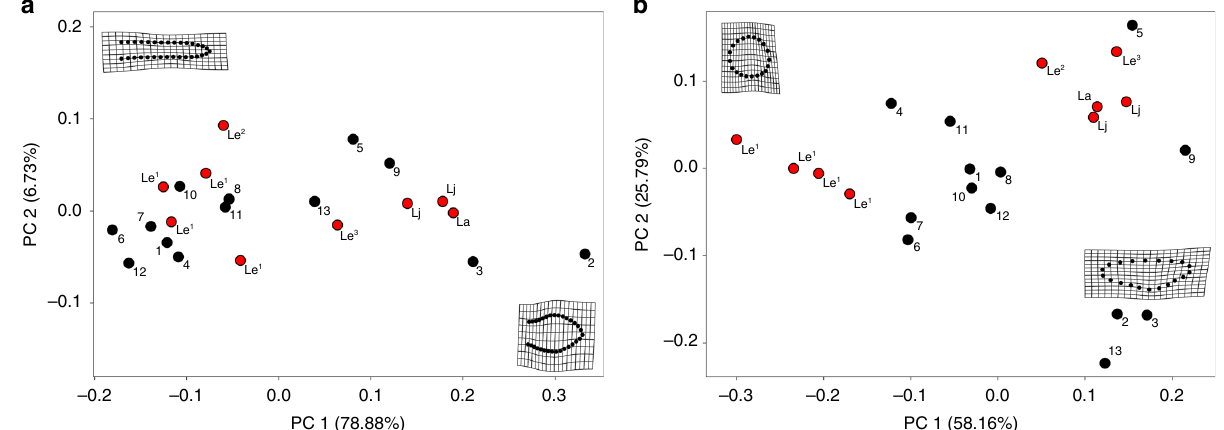
Fig. 5 Geometric morphometric analysis of embryonic and adult sauropodomorph dentition. a PC1 versus PC2 of tooth outline (85.61% of the total variation). b PC1 versus PC2 of crown cross-section (83.95% of the total variation). Deformation grids represent morphologies at the positive and negative extremes of PC1 in each plot. Numbers indicate: 1, Abydosaurus ; 2, Amygdalodon ; 3, Bellusaurus ; 4, Bonitasaura ; 5, Camarasaurus ; 6 and 7, Diplodocus ; 8, Kem Kem Titanosaur; 9, Mamenchisaurus ; 10, MML PV 1030; 11, Nemegtosaurus ; 12, Rapetosaurus ; 13, Shunosaurus . Letters indicate: Le 1 , Lufengosaurus embryonic tooth stage 1; Le 2 , Lufengosaurus embryonic tooth stage 2; Le 3 , Lufengosaurus embryonic tooth stage 3, data taken from the mandible; Lj, Lufengosaurus juvenile, data taken from CVP 148-4; La, Lufengosaurus adult, data taken from CVP 148-6.